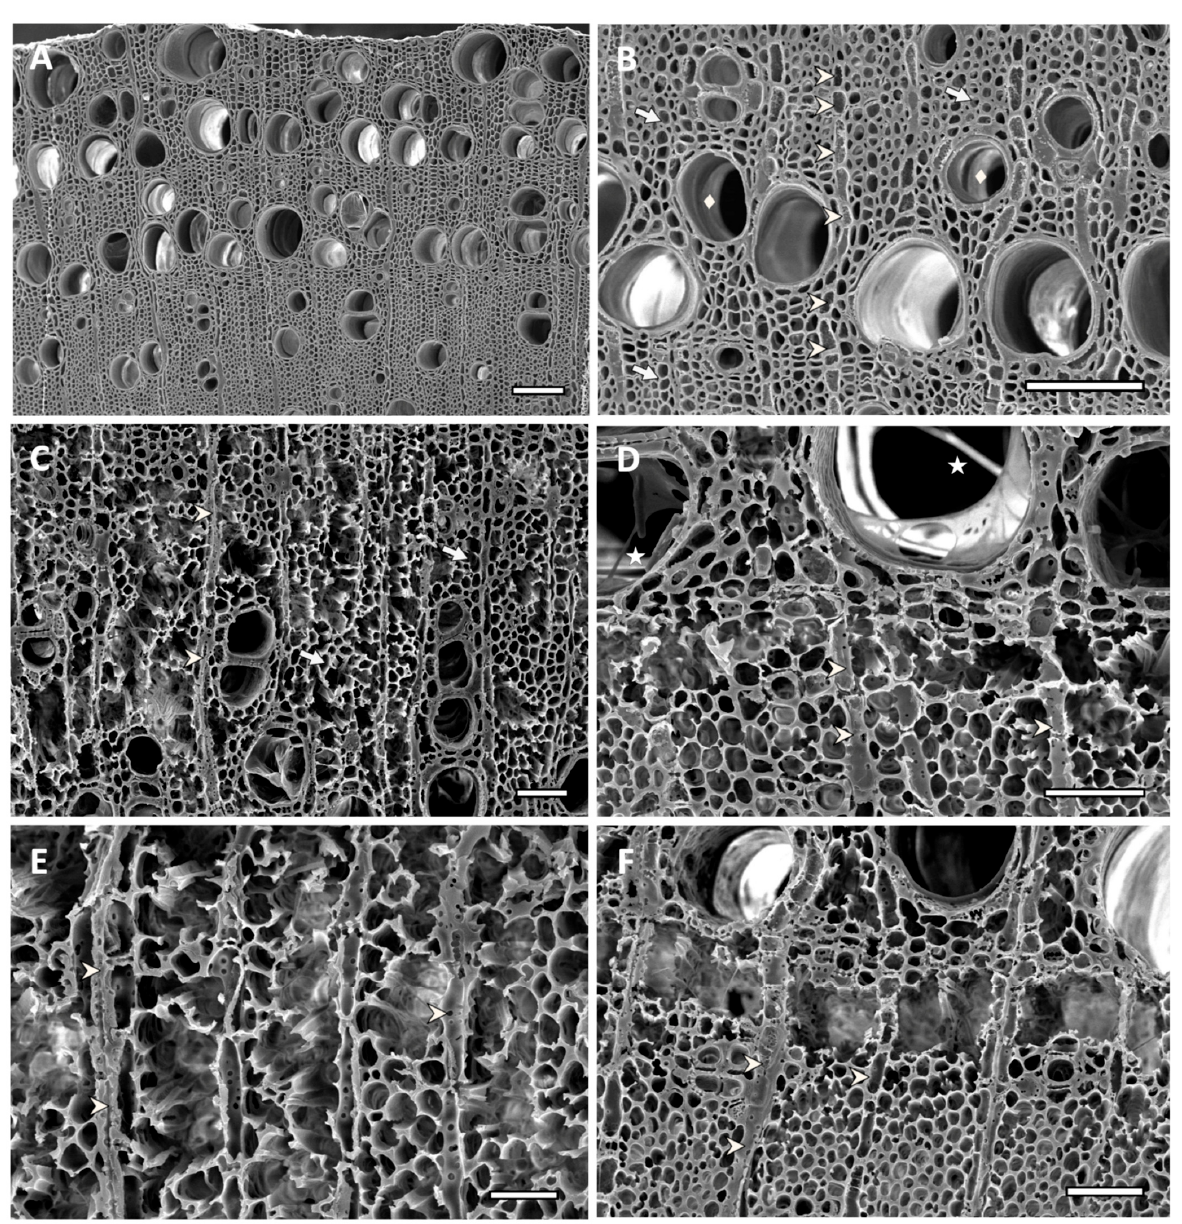
Figure 7. Scanning electron micrographs of transverse sections of ash sapwood disc samples. Arrow indicates fibers, arrowhead indicates ray parenchyma, diamond shape indicates vessels and star